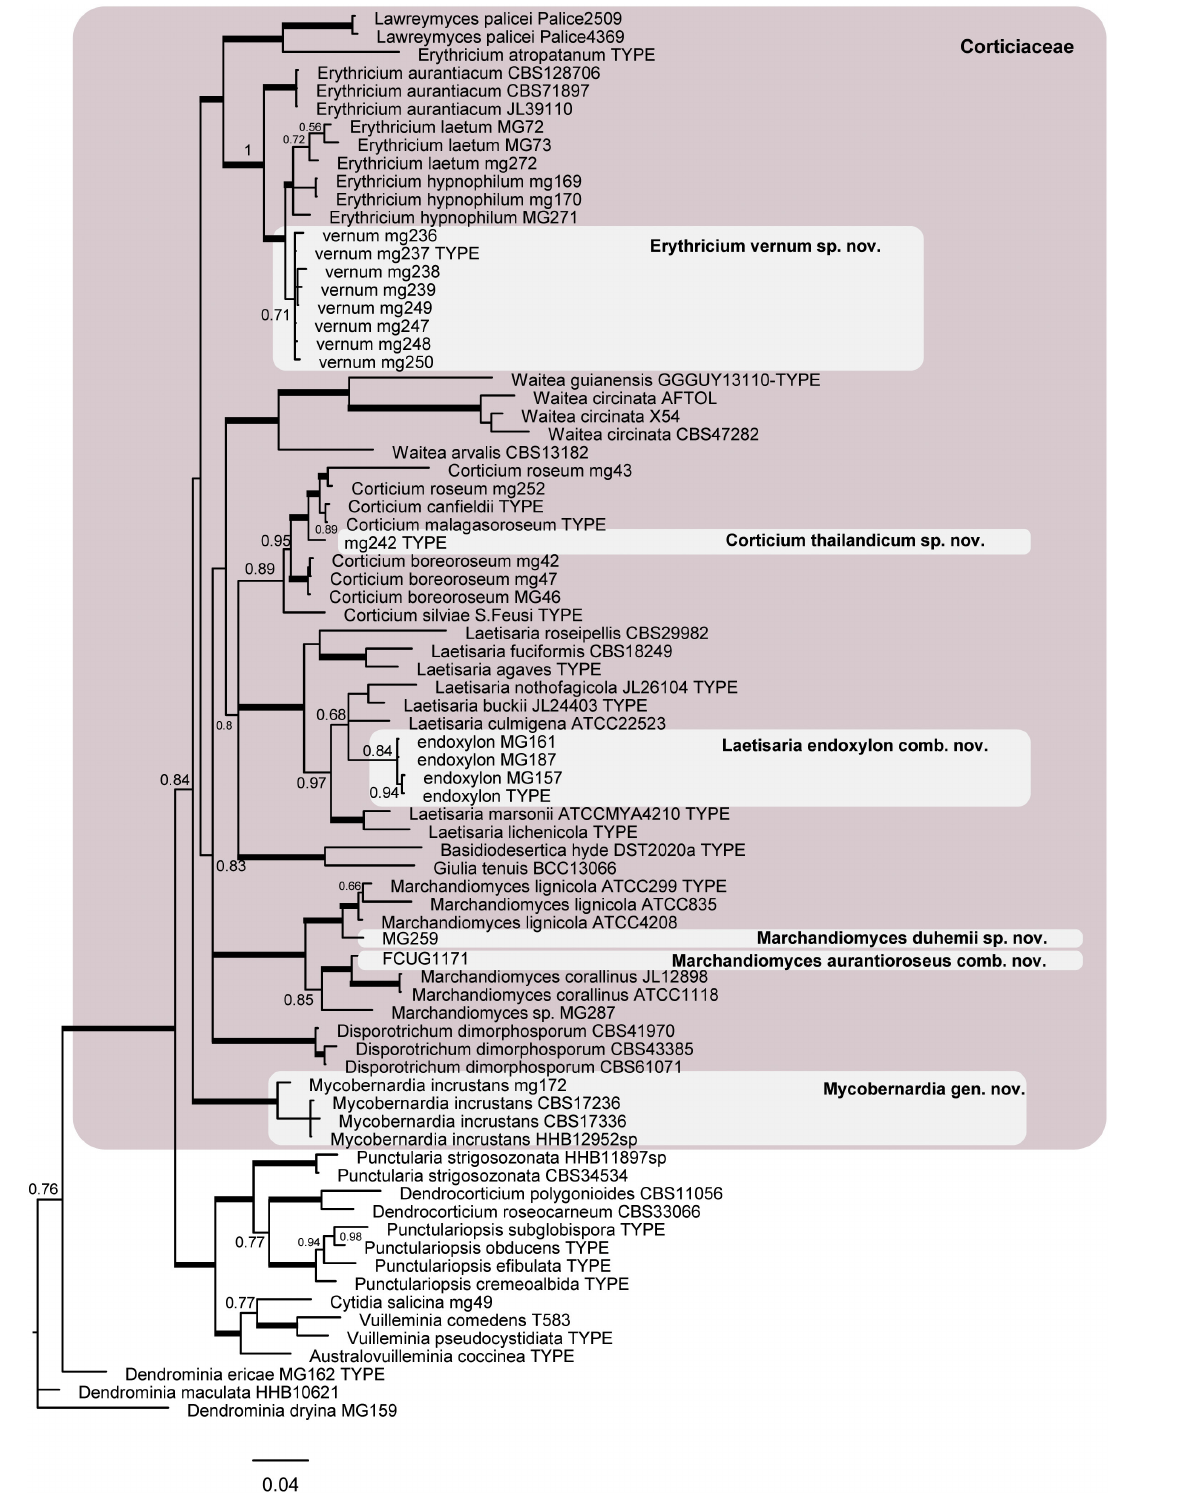
Frontiers in Microbiology | www.frontiersin.org